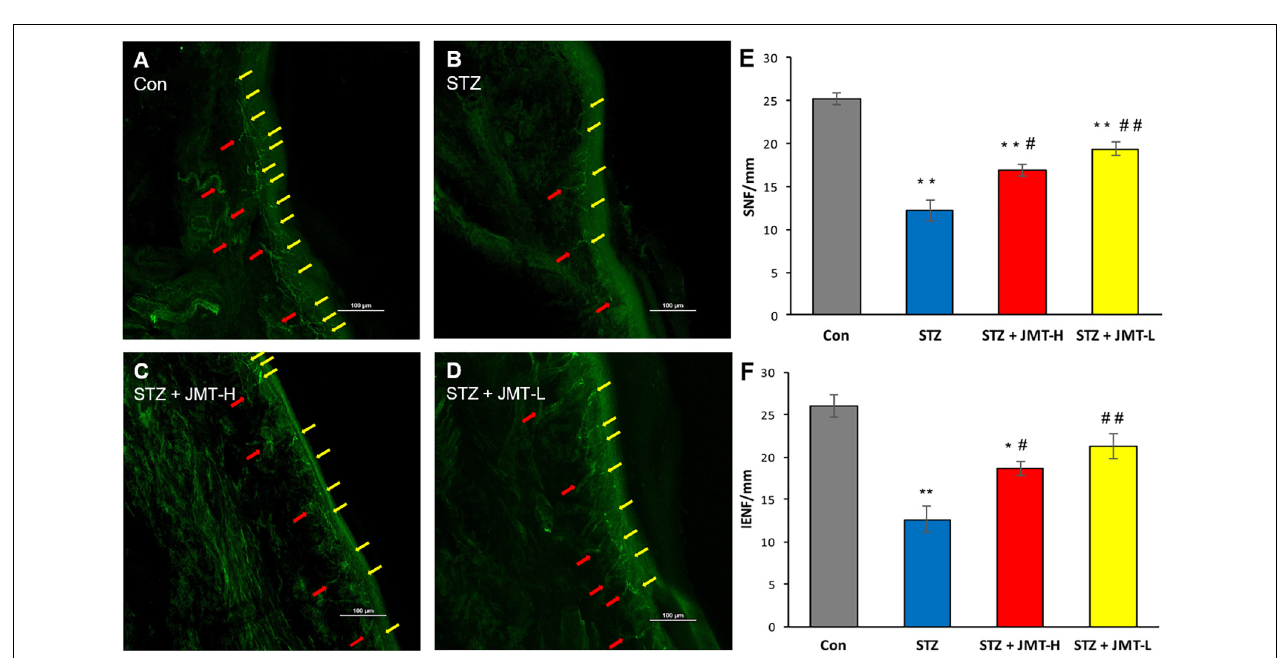
FIGURE 2 | Histological examination of sciatic nerve in the cross-sectional (A–D) and longitudinal (E–H) view. Normal myelinated fibers of sciatic nerves were arranged in a dense and wrapped with myelin (yellow arrows). Sciatic nerves of DPN rats exhibited obvious vacuolar-like defects (blue arrows), demyelination changes and axonal shrinkage (green arrows). Magnification: 40 × , scale bars: 20 µ m (cross section), and 50 µ m (longitudinal section).